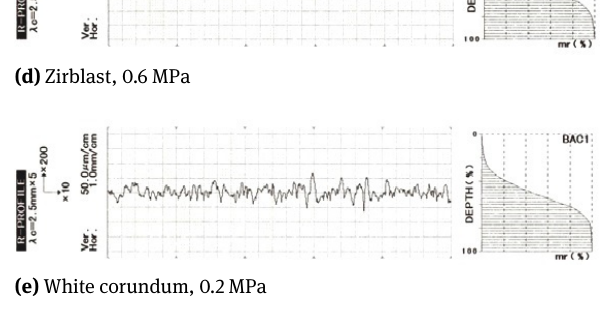
Figure 5: The effect of pressure on the value of the parameter Rz.